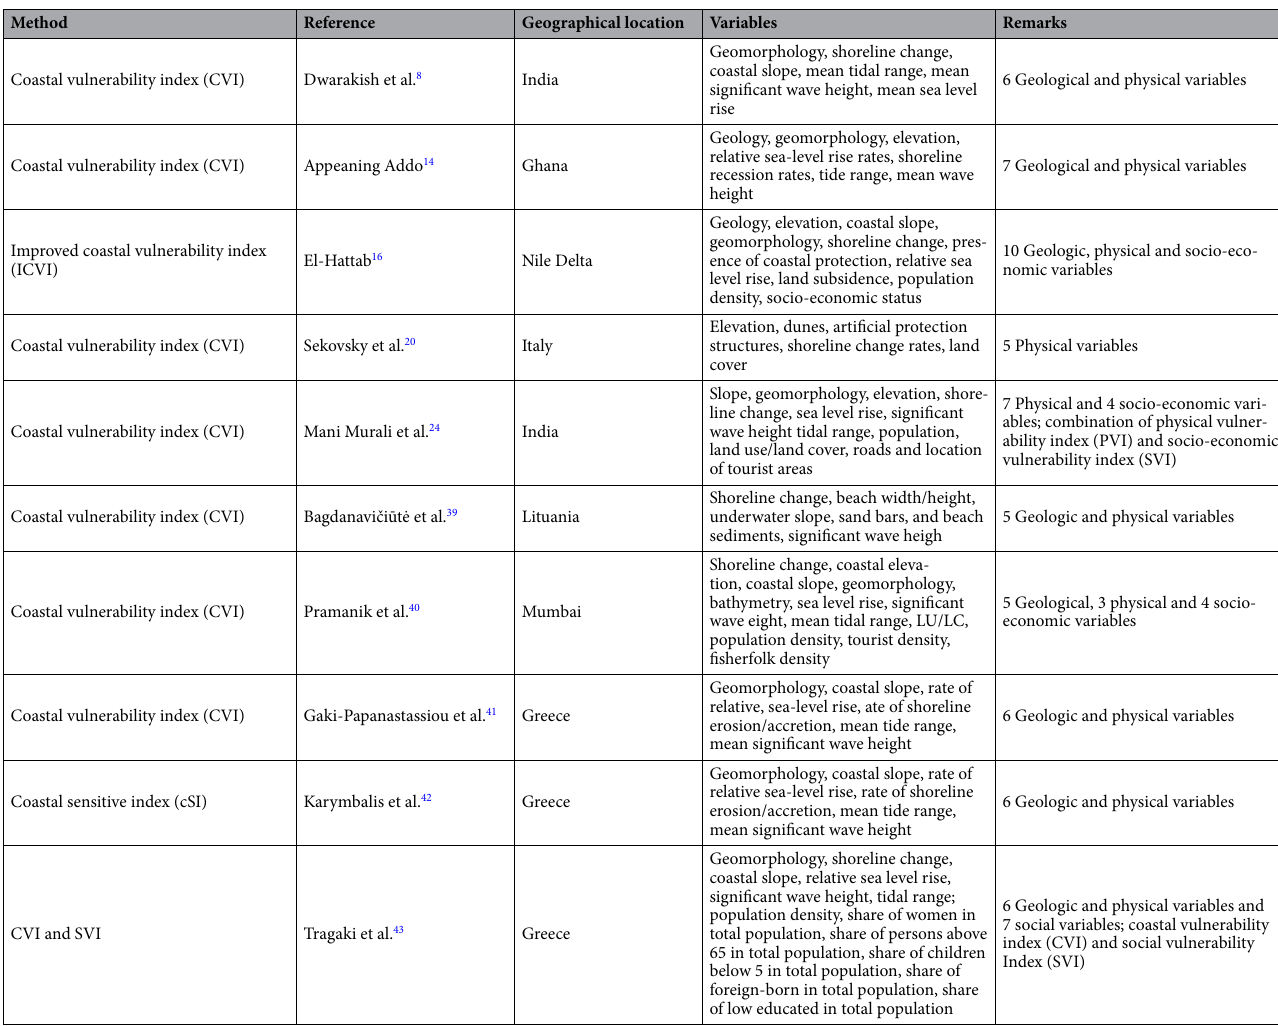
Table 1. CVI formulations applied to low-lying